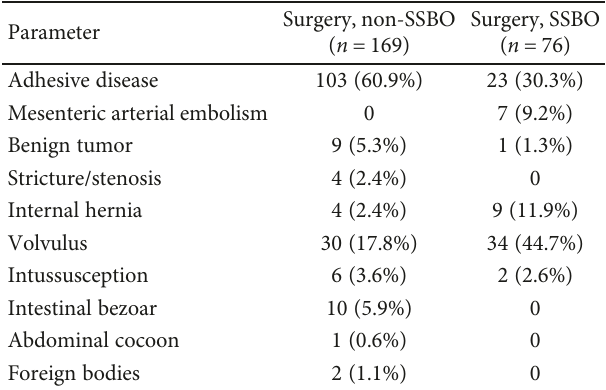
Table 1: Etiology of patients who underwent